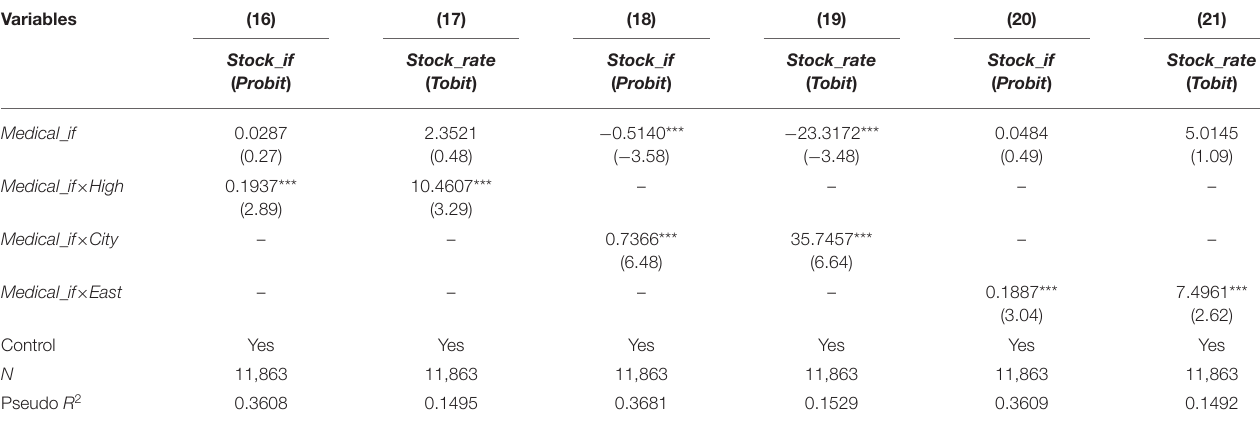
TABLE 7 | Results of heterogeneity analysis.